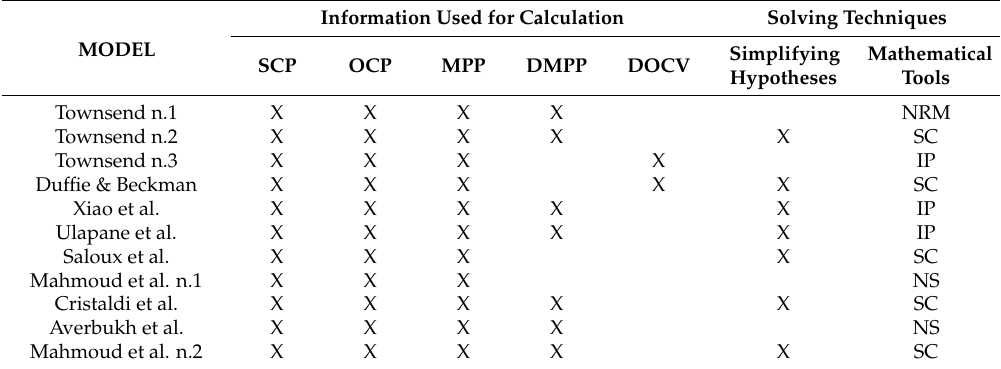
Table 1. Summary of the information and solving techniques used by the simplified one-diode